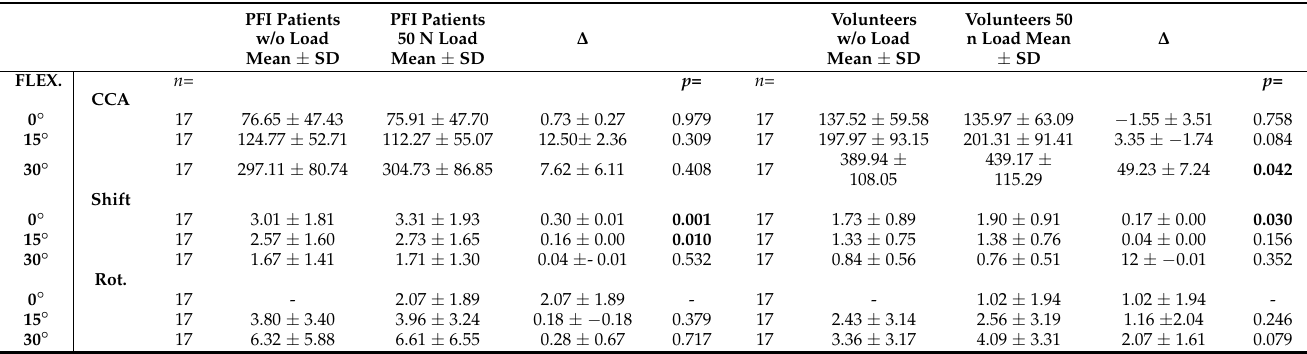
Table 3. Overview of parameters (mm 2 ) without and with quadriceps activation (50 N).